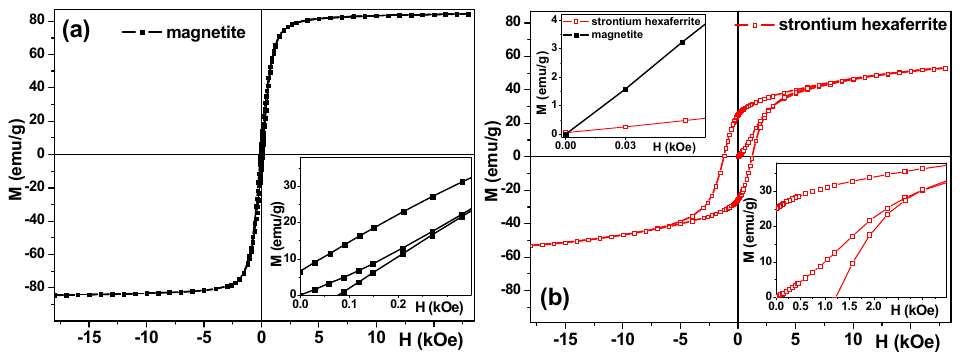
Figure 5. XRD patterns of commercial “magnetite” particles (top) and different phases identification as a result of peaks de-convolution using the databases identification for all observed phases (see also Table 2).